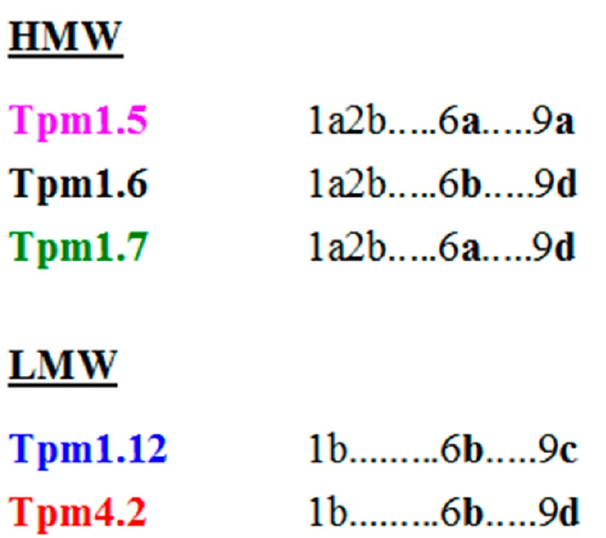
Figure 1. Schematic representation of exon usage for Tpm isoforms used in this study. Variable exons 6 (6a or 6b) and 9 (9a, 9c or 9d) are only shown.